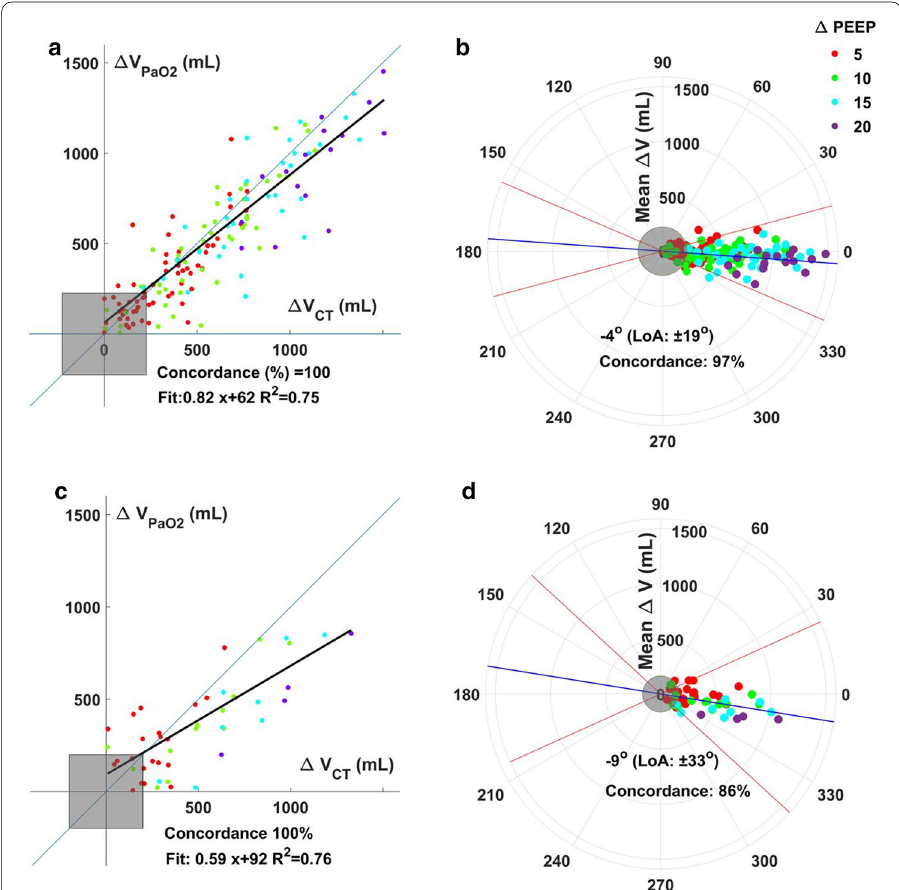
Fig. 5 Volume changes (Δ V PaO2 and Δ V CT ) in the control animals ( a , b ), and in the saline lavage lung injury model ( c , d ). Individual points represent a paired set of measurements and different colours represent changes associated with different ΔPEEP in each animal. a , c Black solid lines are the regression lines, and blue lines are the identity lines. b , d The stronger the agreement between two measurements, the closer the data are to the horizontal line (0°). b , d Blue lines are the mean angular bias, and red lines are the upper and lower limits of agreement; good concordance is assumed to be within 30° of the horizontal zero line. LoA limits of ±